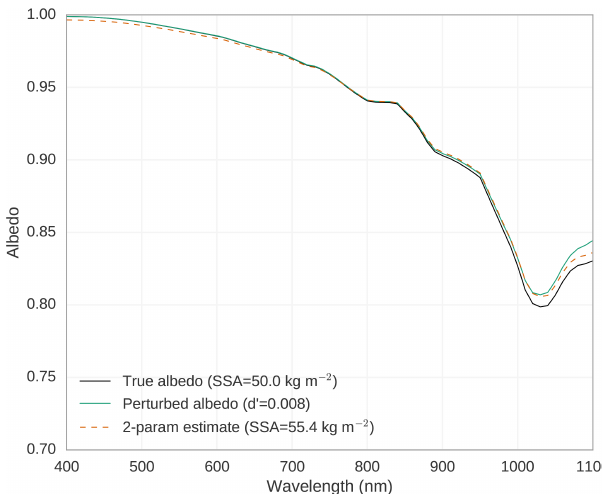
Figure 11. Simulations of albedo spectrum for a SZA = 60 ◦ . A perfect albedo spectrum for an homogeneous snowpack with SSA of 50m 2 kg − 1 (black) is perturbed (green) by adding an offset of d (cid:48) = 0 . 8% of the maximum incident irradiance to the incident and reflected irradiance. It is used as an observation to estimate SSA using the range 700–1050nm. The estimated spectrum is shown in orange (long